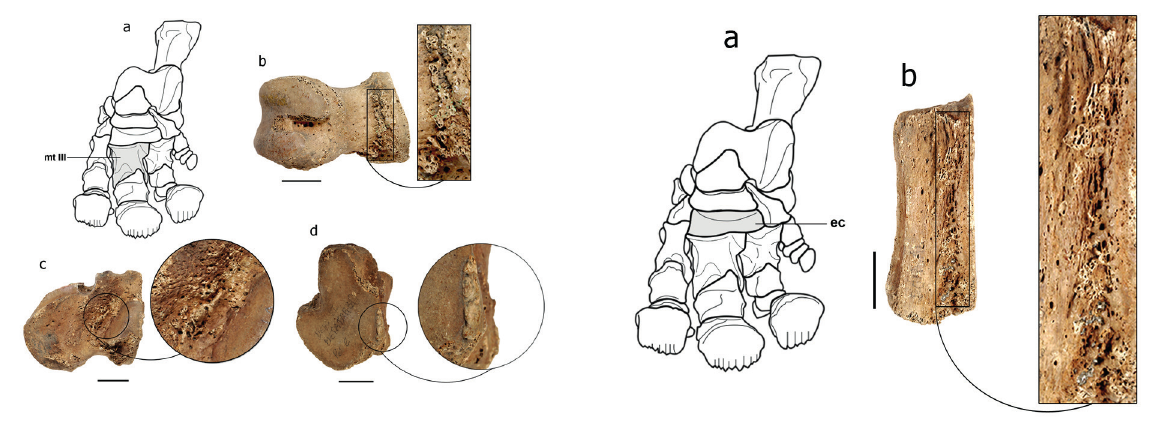
An Acad Bras Cienc (2019) 91(Suppl. 1) e20160812 3 | 6